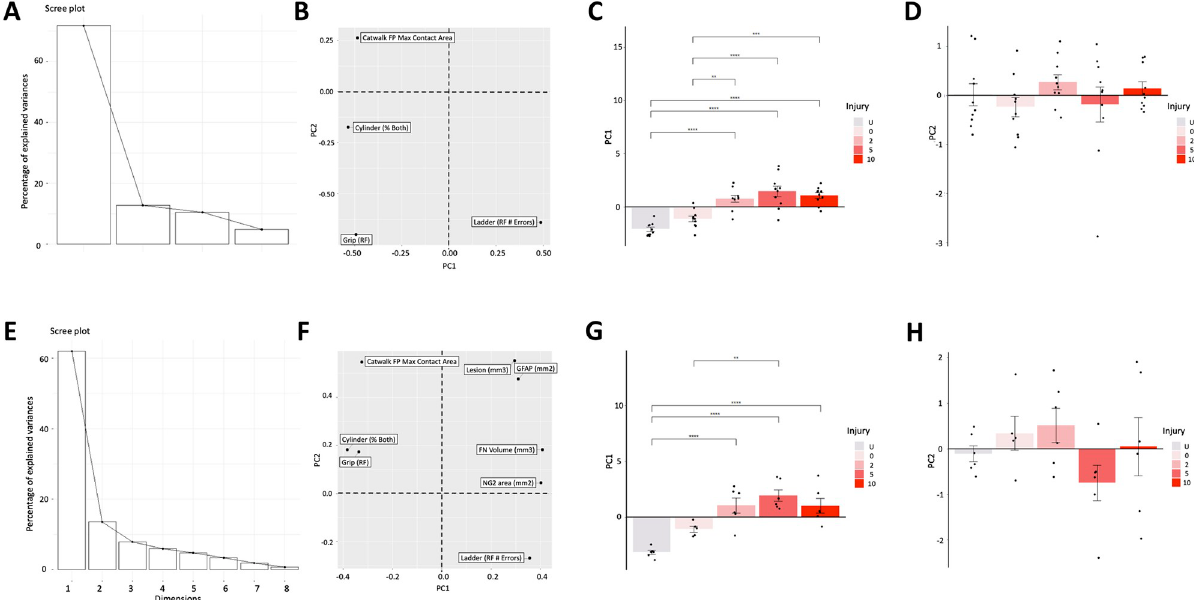
Fig 5. Multivariate analysis of the unilateral cervical contusion injury in mice (C57BL/6) at 8 weeks post-SCI. The scree plot (A), loading magnitude (B) and 2D plots of PC1 (C) as well as PC2 (D) on their own axes for pooled behavioral outcomes. The scree plot (E), loading magnitude (F) and 2D plots of PC1 (G) as well as PC2 (H) on their own axes for pooled behavioral combined with lesion histological outcomes. The retained PCs were used to score each subject, and the resulting mean scores for each injury group were plotted, and one-way ANOVA with post-Hoc HSD tests used to test for significant differences between individual groups; � , p � .05; �� , p � 0.01; ��� , p � 0.001; ���� , p � 0.0001.